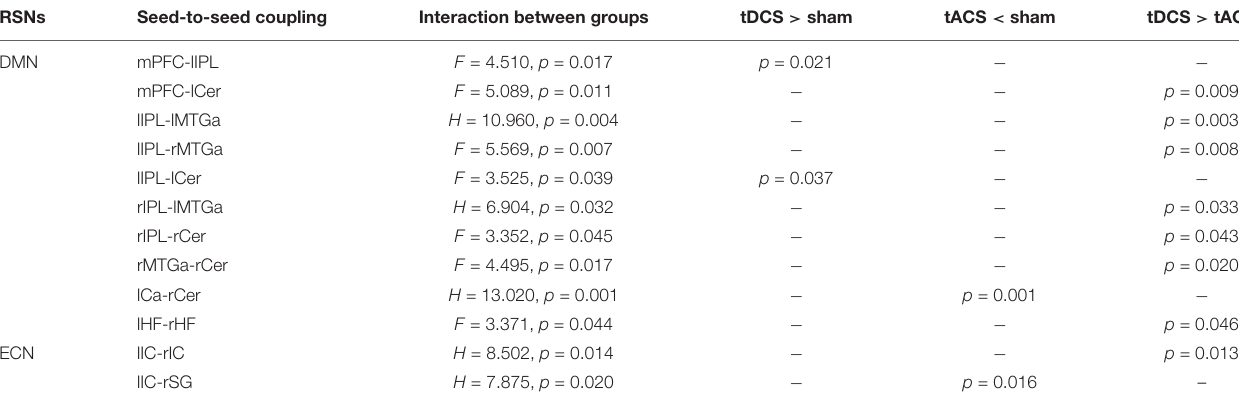
TABLE 3 | Seed-to-seed connections with statistically significant interactions and subsequent significant pairwise post hoc analyses within the DMN and the ECN. RSNs Seed-to-seed coupling